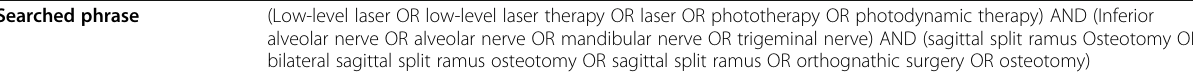
Table 1 Full search strategy for electronic databases Searched